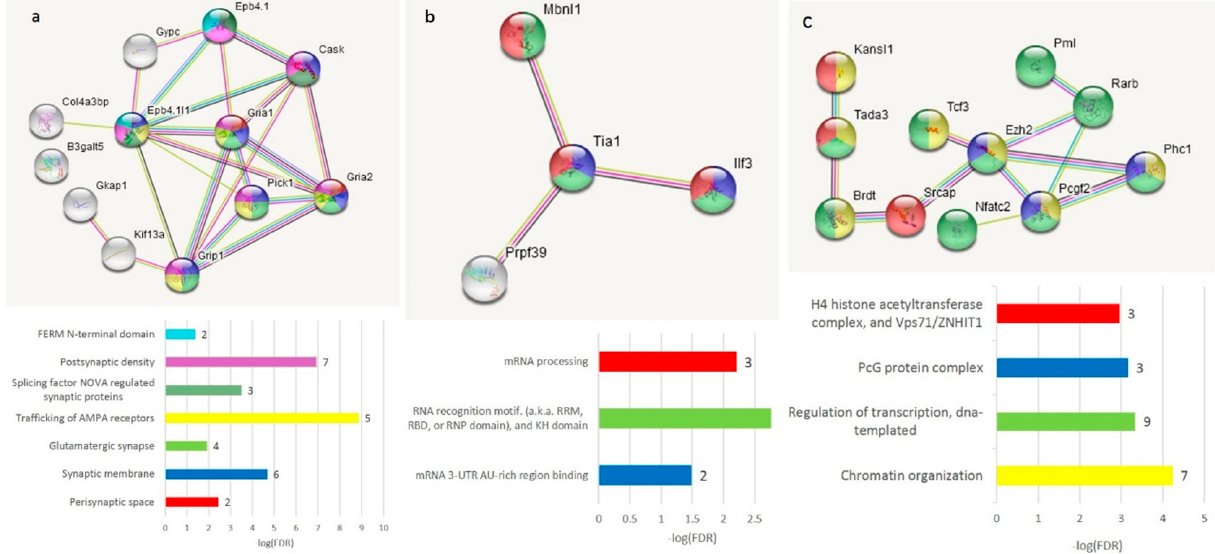
Figure 7. Three expanded connected neighborhoods of the DAS ES genes elevated in A20 subjects (Figure 6b) signifies ( a ) enrichment with synaptic DAS ES genes; ( b ) mRNA processing enzymes; and ( c ) chromatin rearrangement of DAS genes. Color codes correspond to the bar plot below and the number of observed DAS ES genes are shown as bar